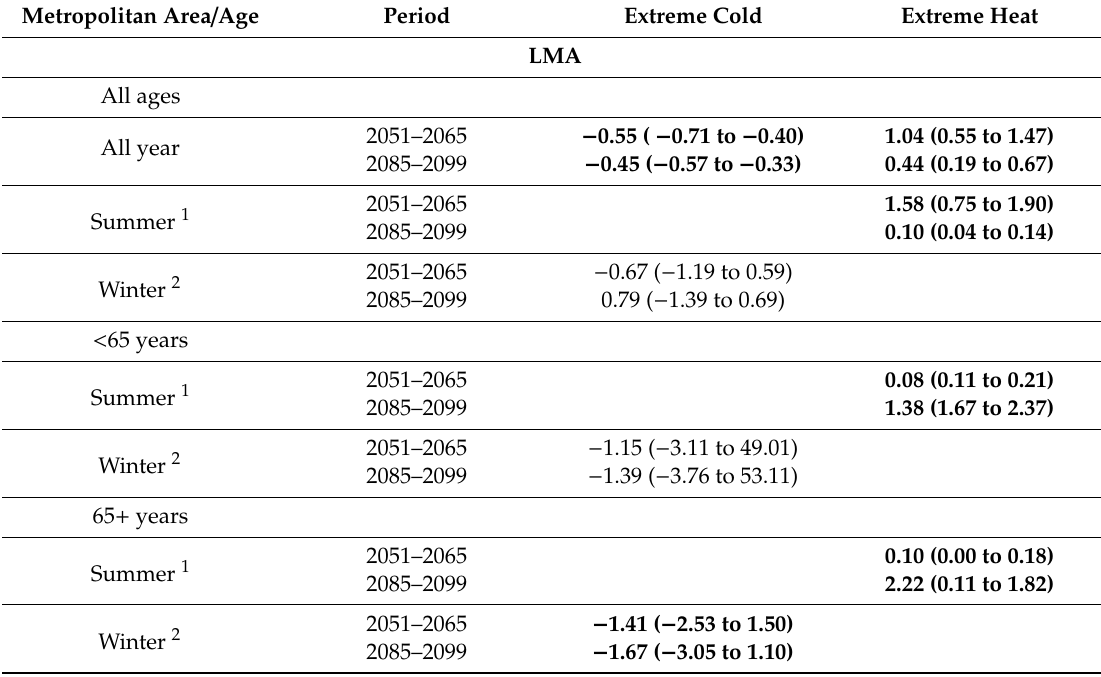
Table 4. Changes in temperature-attributable mortality (%) in the future periods (2051–2065